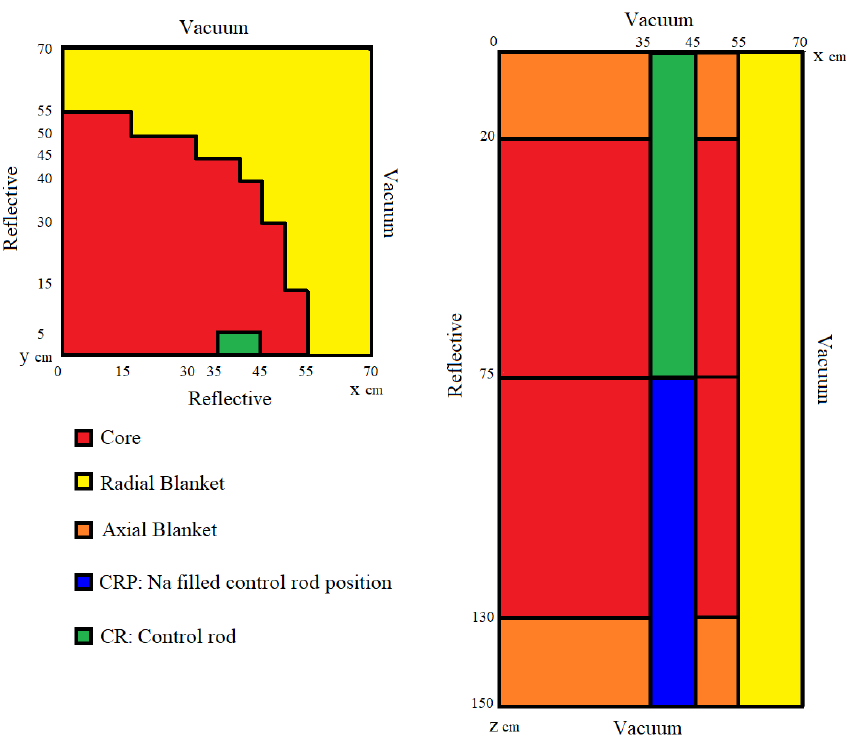
Figure 5. Core configuration of Small FBR core.